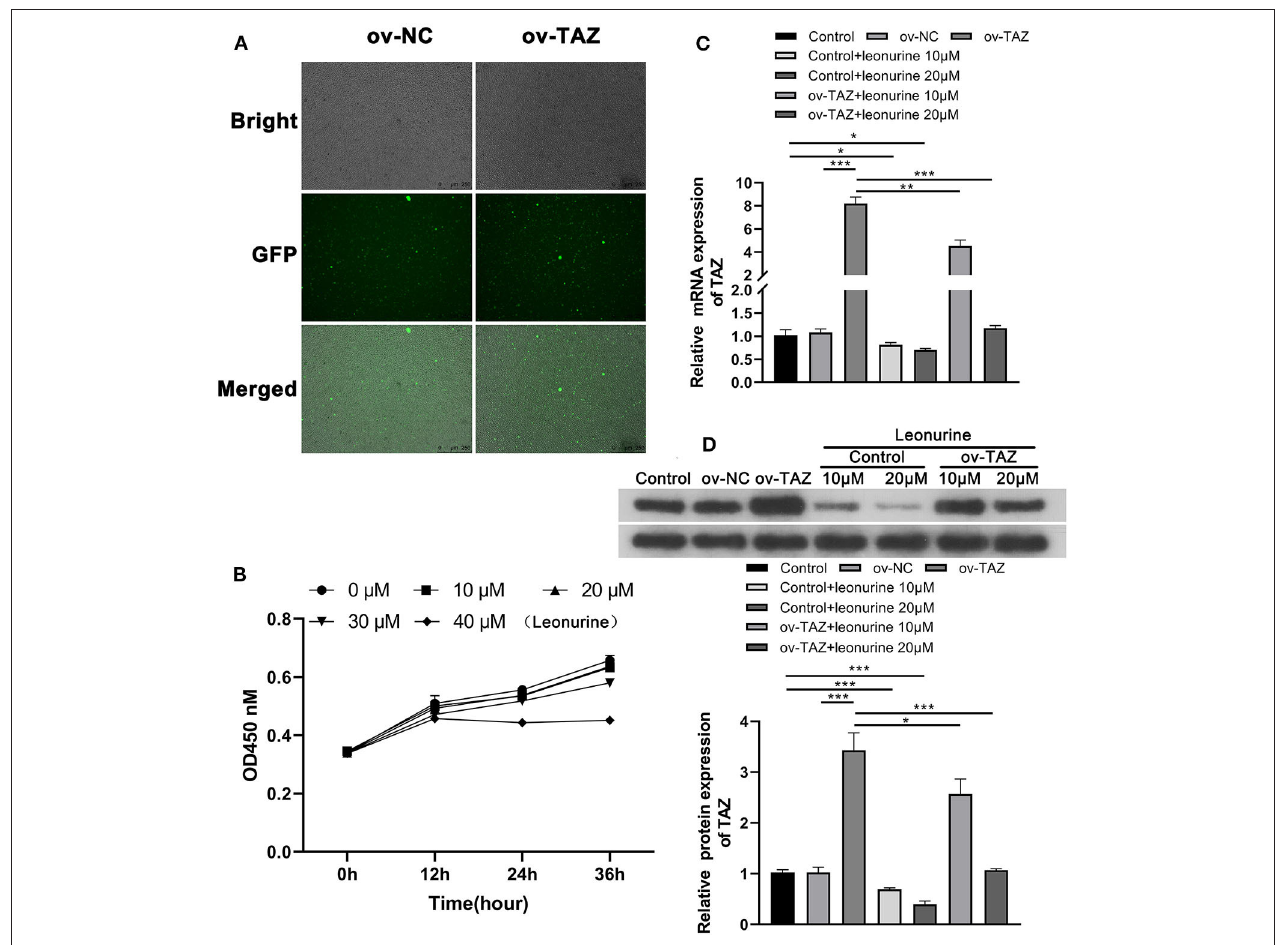
FIGURE 2 | Leonurine treatment reduced the expression of TAZ in T cells. (A) 293 T-cells stably expressing TAZ previously established by transfection were used as a positive control (ov-TAZ) and a negative control (ov-NC) (magnification, × 100). (B) MTT assays showed that leonurine had the least cytotoxicity at 20 µ M. There was no difference in suppression of proliferation between the leonurine 20 and 10 µ M groups ( P > 0.05), while leonurine 30 µ M group was significantly different from the leonurine 20 µ M group ( P < 0.05), and the leonurine 0 µ M groupwas used as a negative control. (C,D) qPCR and Western blot results showed that the expression